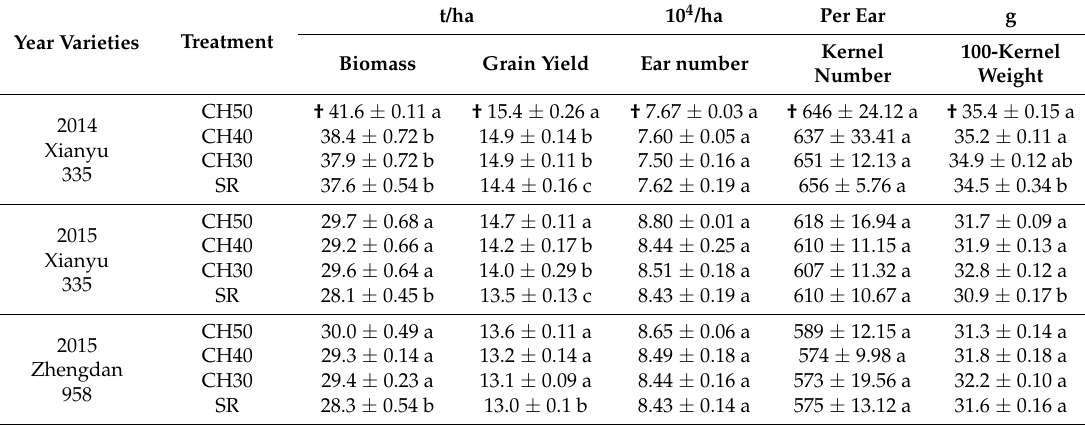
Table 6. Biomass, grain yield, and yield components under different subsoiling treatments. Values are the mean of three replications ± 1 standard